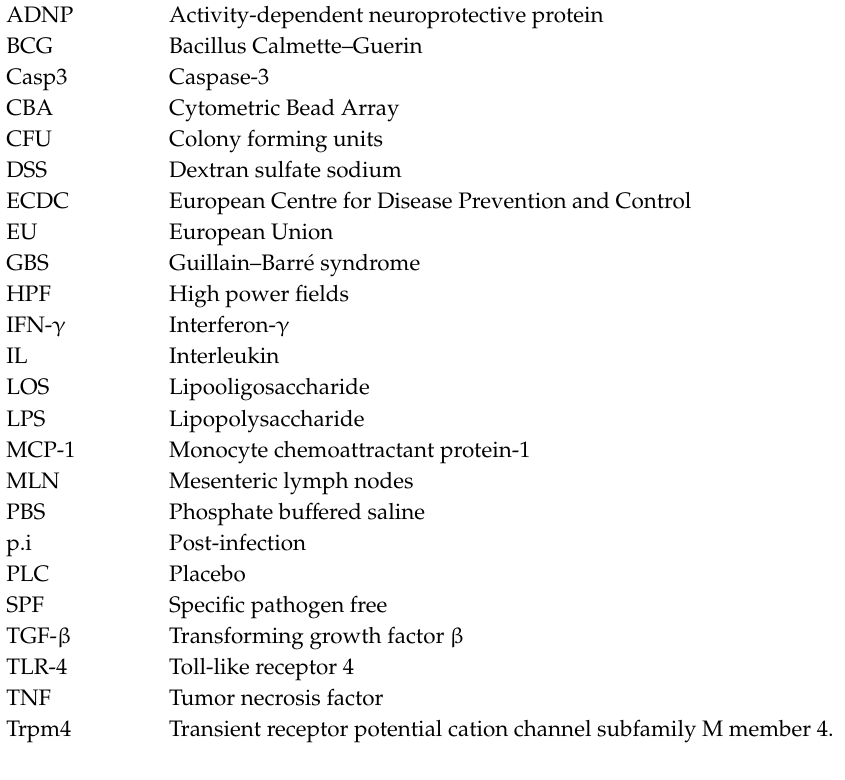
Figure S1: Kinetic survey of fecal pathogen shedding following NAP treatment of C. jejuni infected secondary abiotic IL10 − / − mice, Figure S2: Kinetic survey of clinical conditions following NAP treatment of C. jejuni infected secondary abiotic IL10 − / − mice, Figure S3: Ileal pro-inflammatory mediator secretion following NAP treatment of C. jejuni infected secondary abiotic IL10 − / −